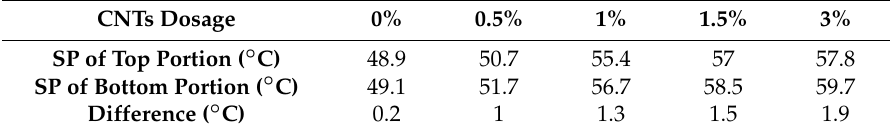
Table 4. Storage stability test data for CNT-modified and unmodified binder.